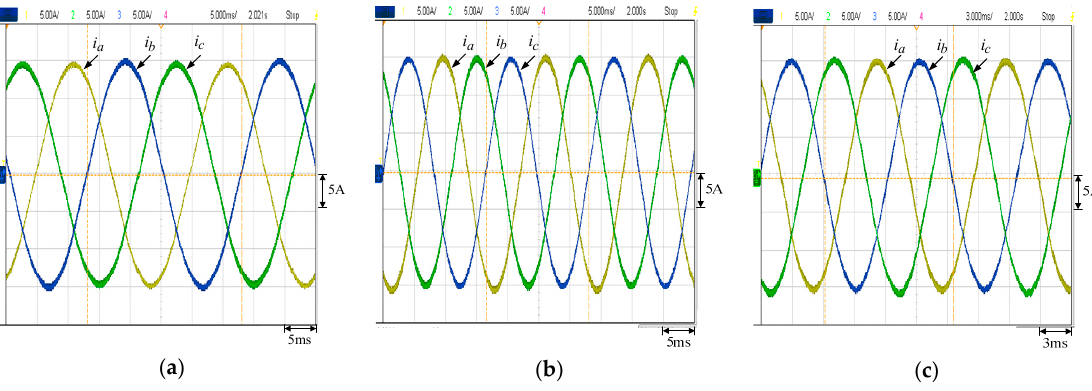
∗ ∗ = 0 A at di ff erent generator speeds: ( a ) i = 0 A at different generator q i = 15 A and d d ∗ ∗ i = 0 A at different generator q i = 15 A and d